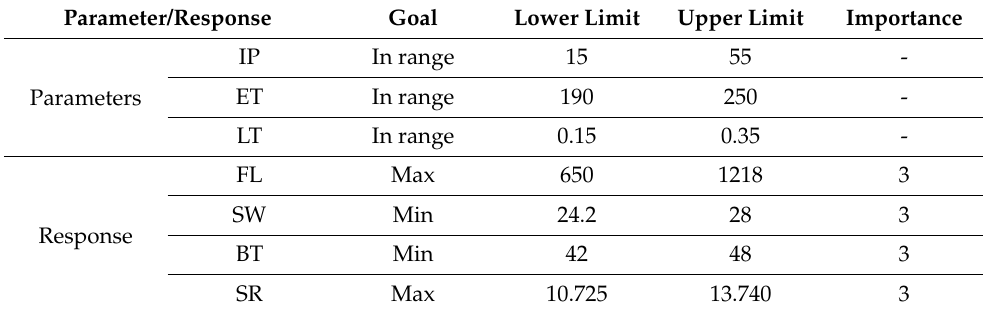
Table 8. Constraints of 3D input and output parameters.